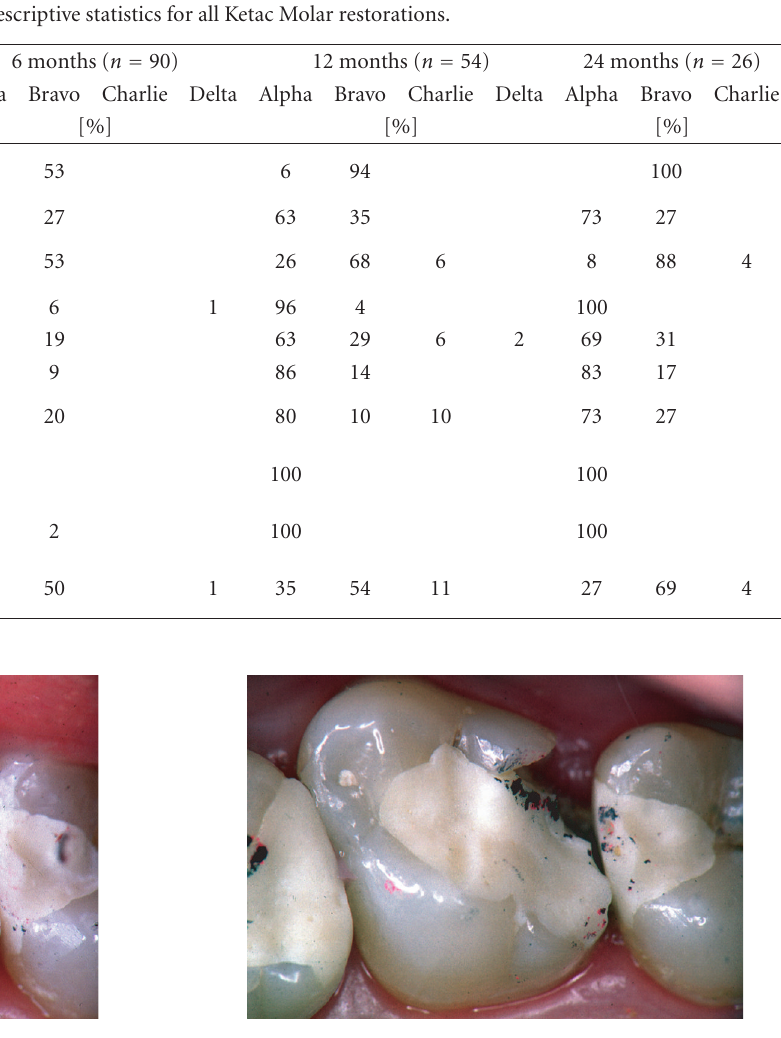
Figure 4: Ketac Molar restoration after 12 months. Half of the proximal box was